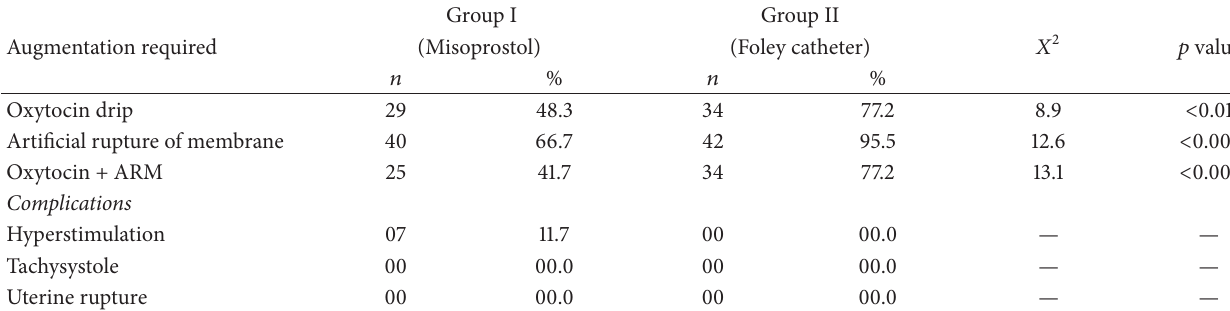
Table 3: Outcome in labour.